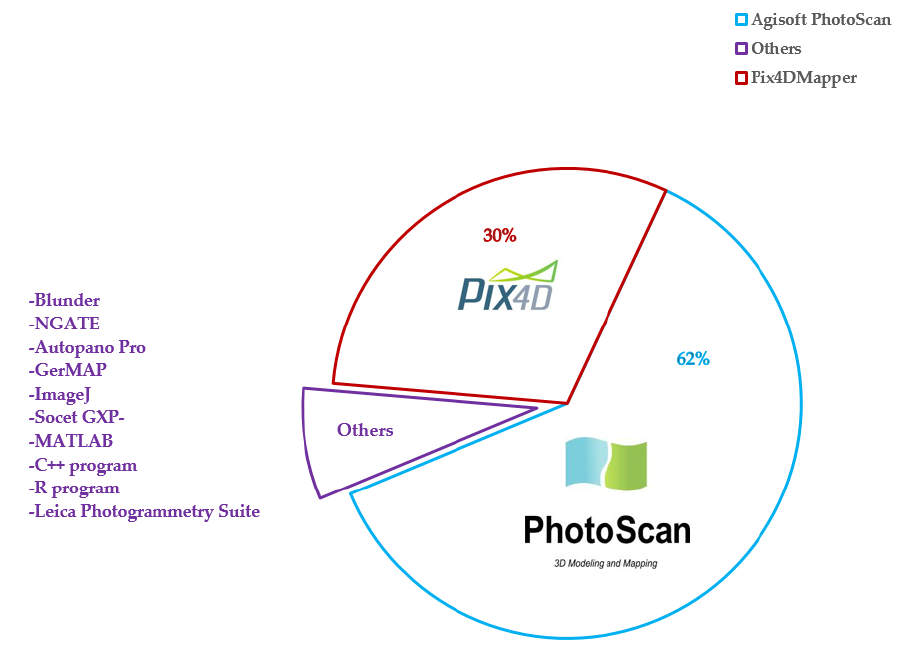
Figure 14. Percentage of case studies in terms of photogrammetry processing software.